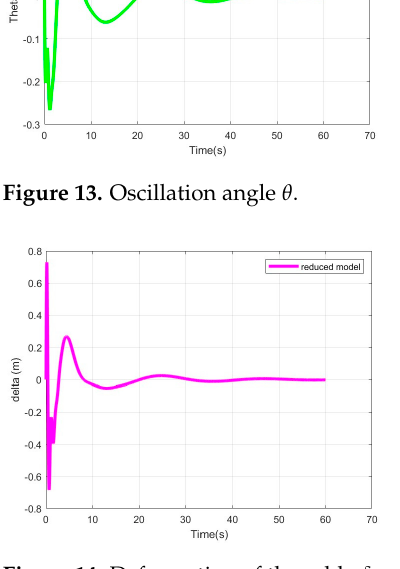
Figure 14. Deformation of the cable